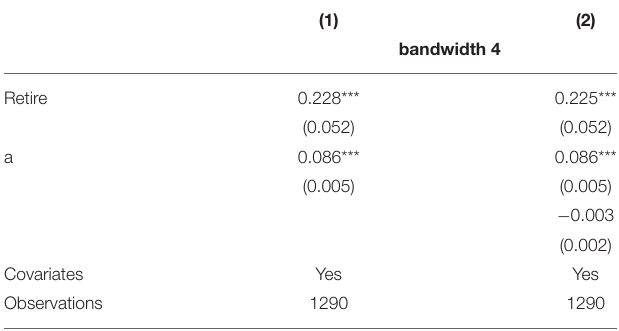
TABLE 4 | FRD estimation